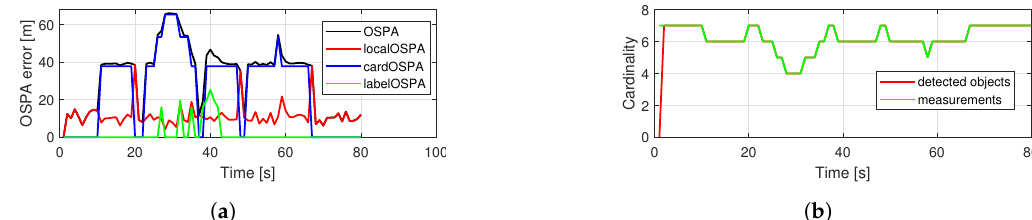
Figure 4. Performance of a single simulation with crossing trajectories using the basic PHD filter. OSPA error ( a ), cardinality statistics ( b ).